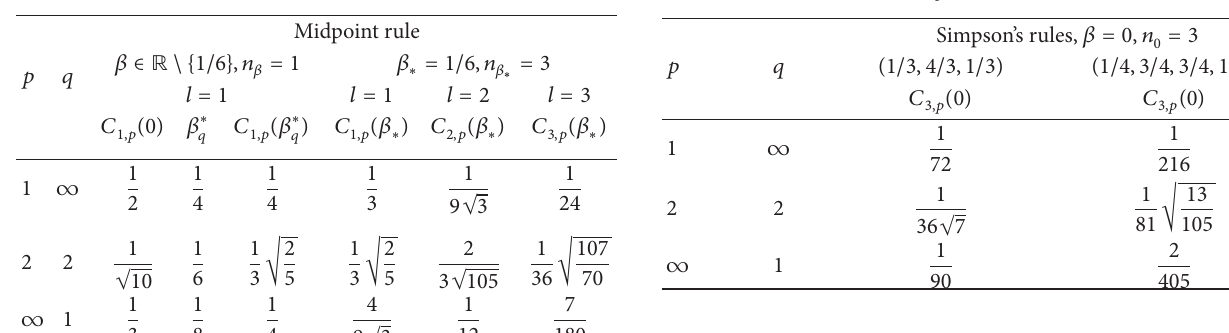
Table 3: Values of 𝐶 3 ,𝑝 ( 0 ) for the Simpson’s